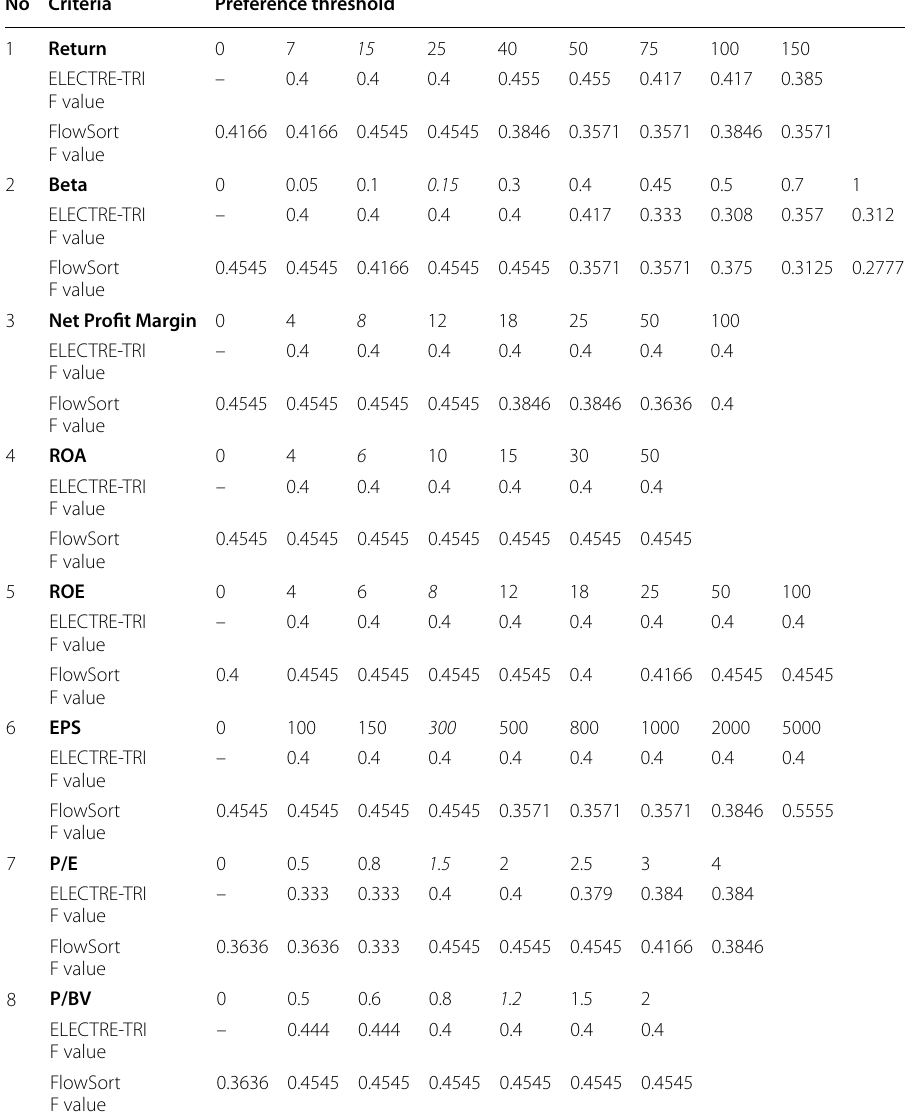
Table 12 Sensitivity analysis on preference threshold No